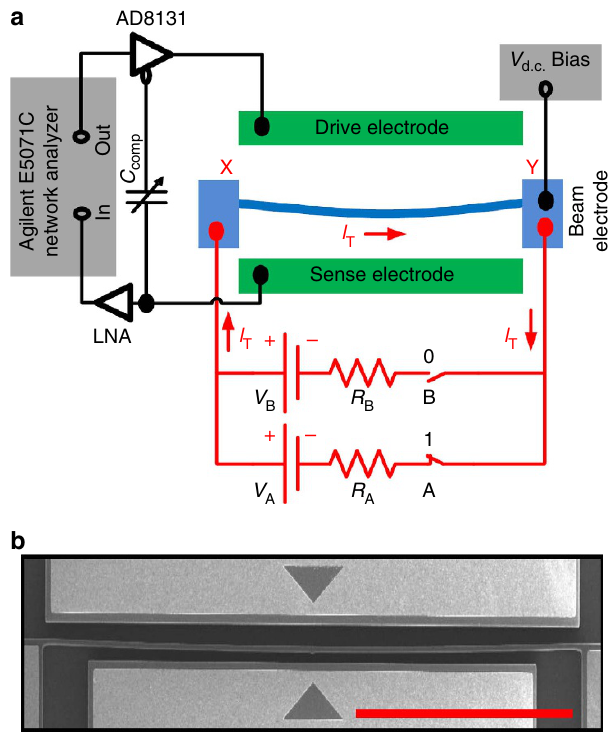
Figure 1 | Clamped–clamped arch resonator. ( a ) Schematic of the arch beam resonator and the two-port electrical transmission measurement configuration together with a parasitic current compensation circuitry using single-to-differential driver (AD8131) and a variable compensation capacitor, C comp . The drive electrode is provided with an a.c. signal from one of the outputs from AD8131 and the beam electrode is biased with a d.c. voltage source. The output current induced at the sense-electrode is coupled with the compensation capacitor and followed by a low-noise amplifier (LNA) whose output is coupled to the network analyser input port. Two voltage sources, V A and V B and switches, A and B are connected in